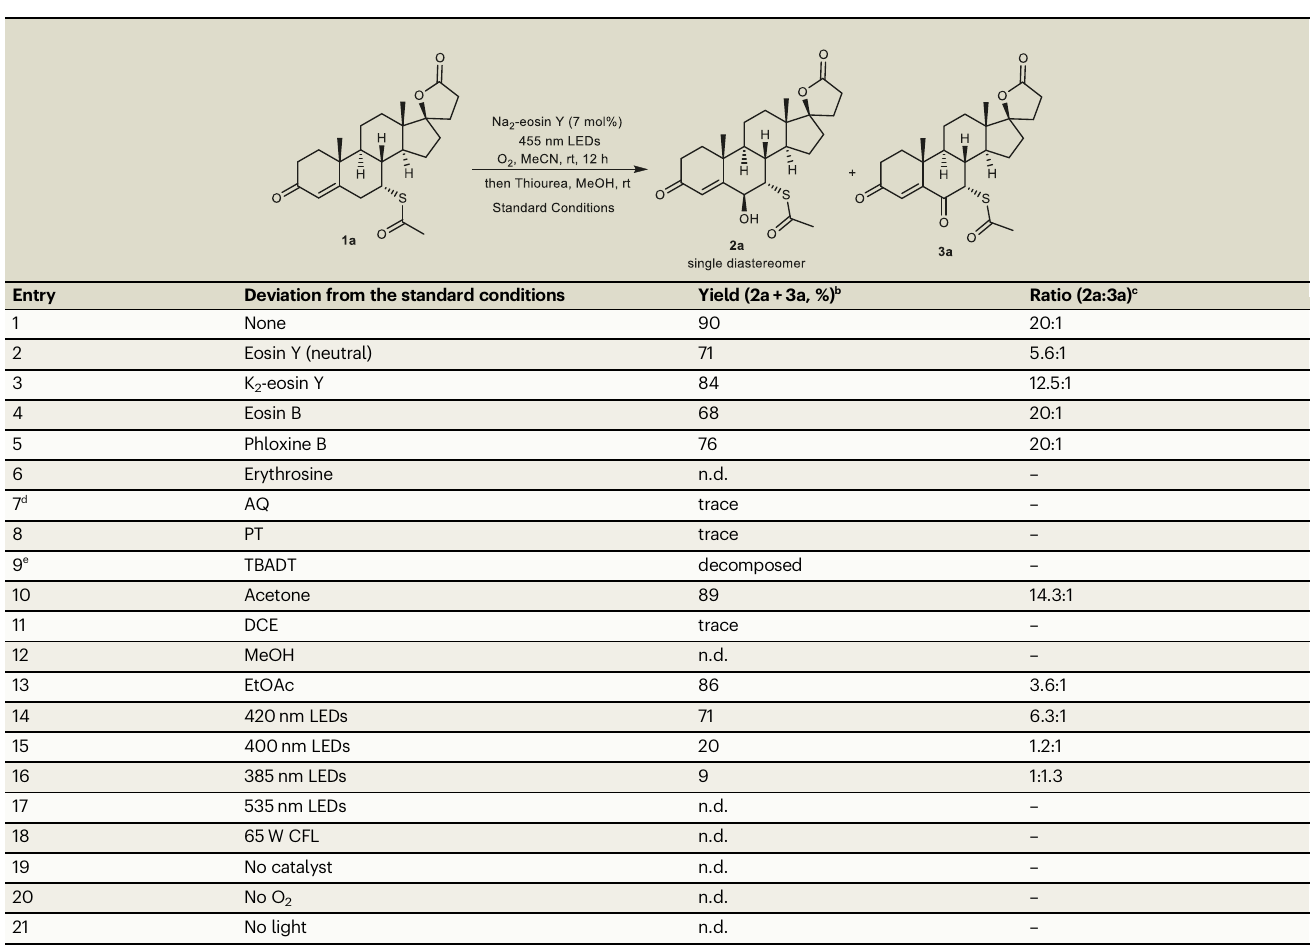
Table 1 | Optimization of reaction conditions for the direct C(sp 3 )-H hydroxylation